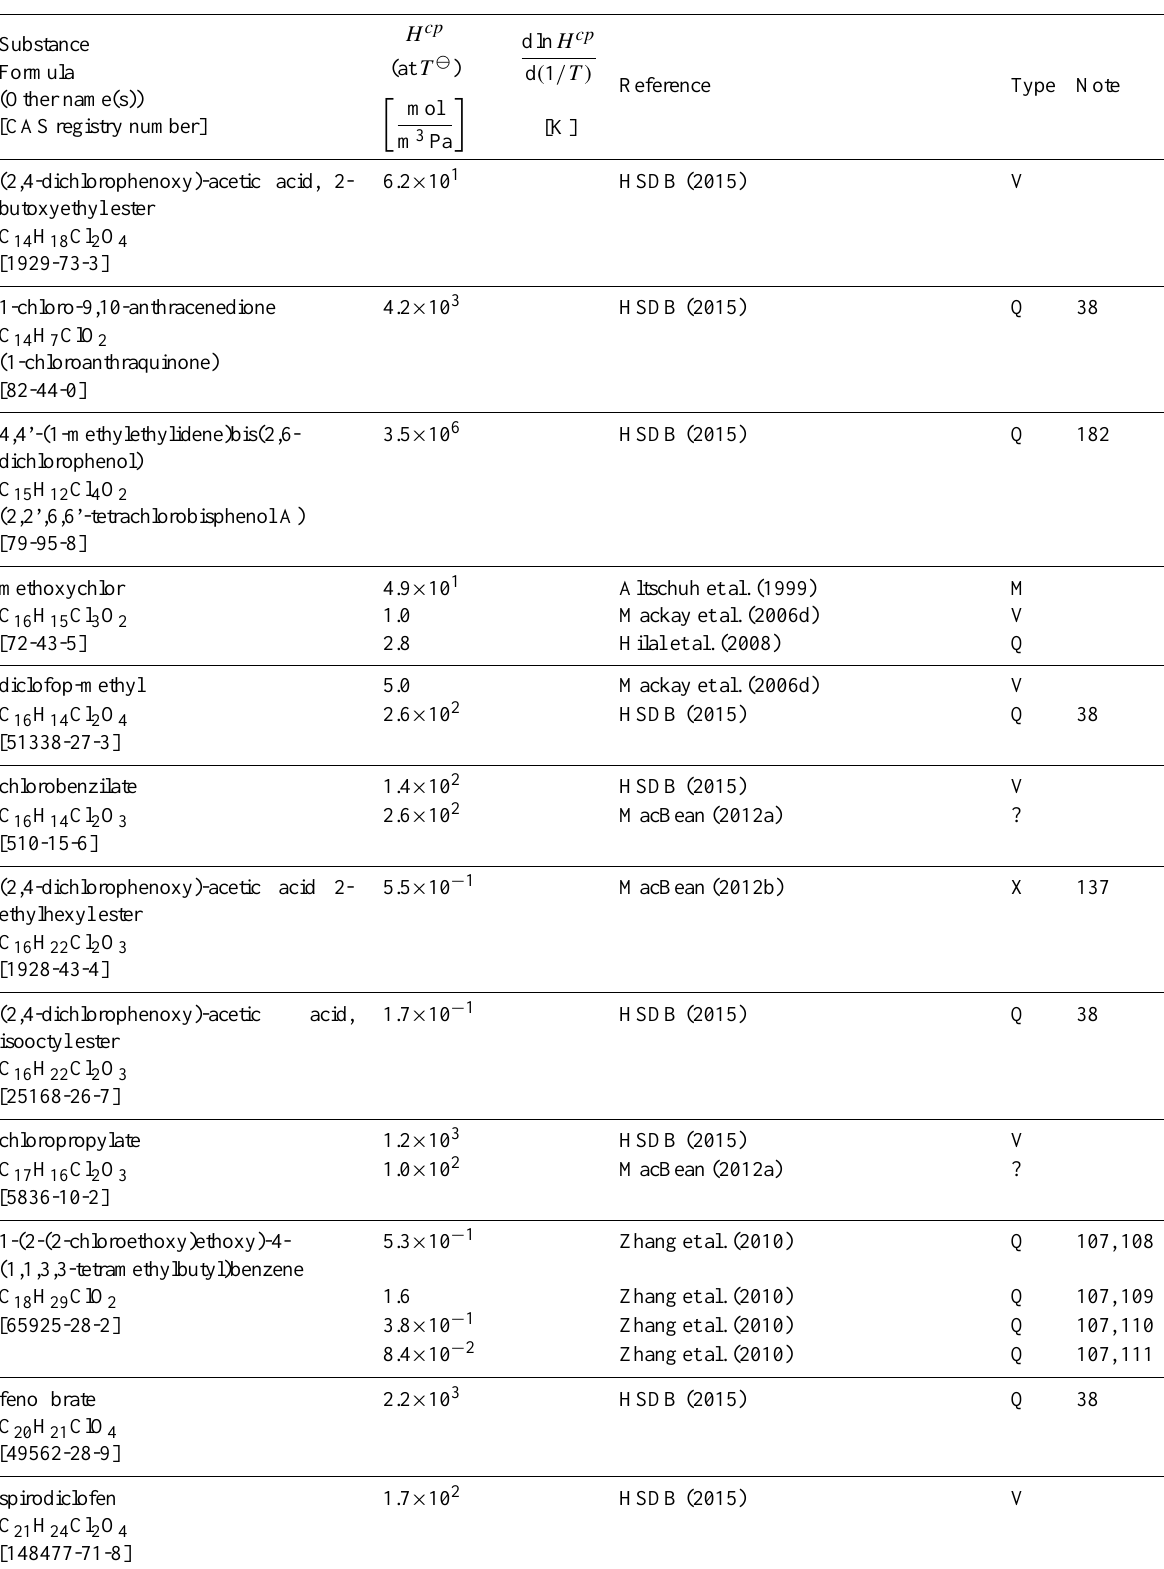
Table 6: Henry’s law constants for water as solvent